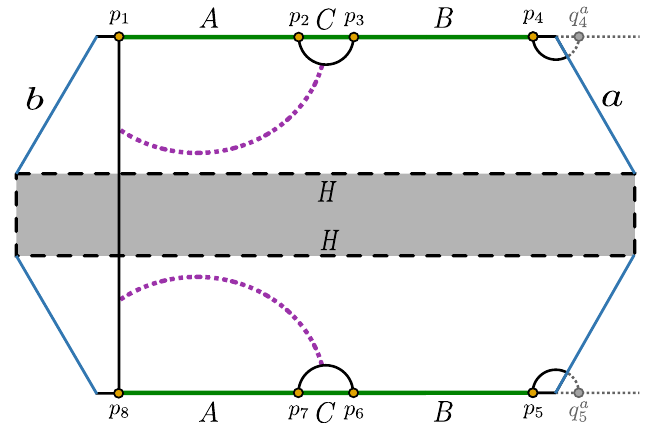
Figure 33 . The endpoints of the intervals A and B and the image points in the two BCFT 2 copies are identified similarly as in figure